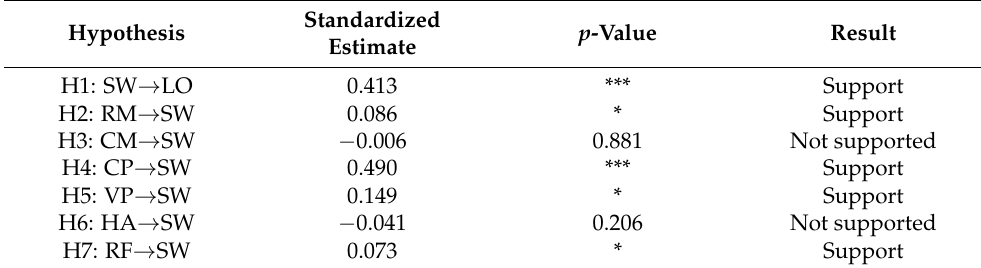
Table 4. The result of hypothesis